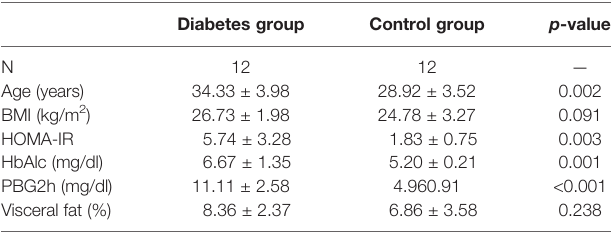
TABLE 2 | General